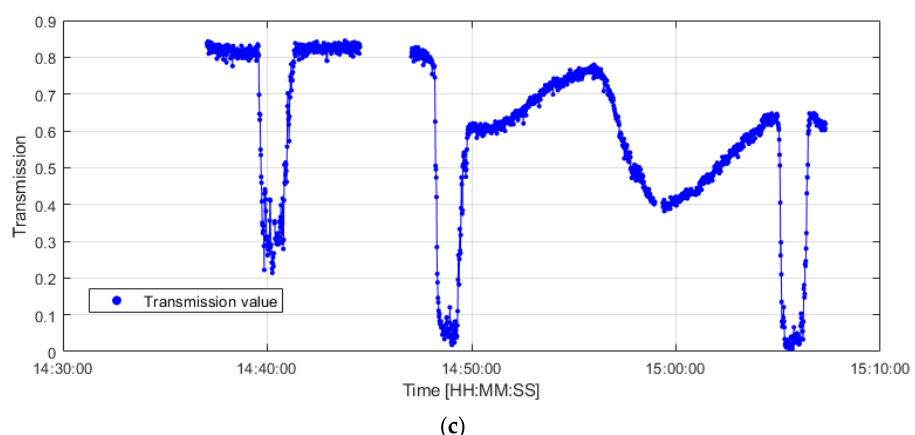
Figure 4. Measurement results: ( a ) turbidity, ( b ) suspended sediment concentration, and ( c ) trans- mission value.